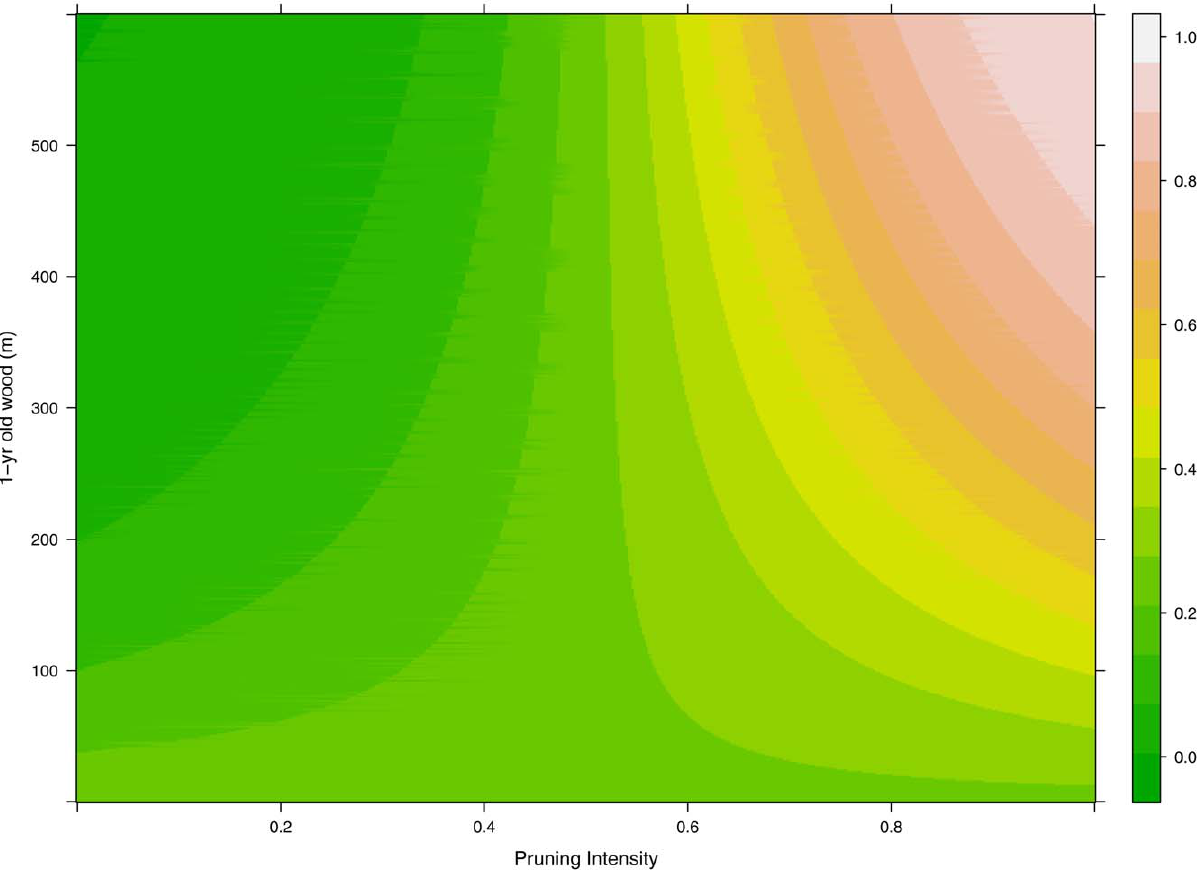
Figure 1. Estimated fraction of long shoots in the growing season (P LS ) of a virtual peach Prunuspersica tree as function of 1-yr old wood before winter pruning (L w1 ) and pruning intensity (PI, i.e. fraction of 1-yr old shoot removed before bud